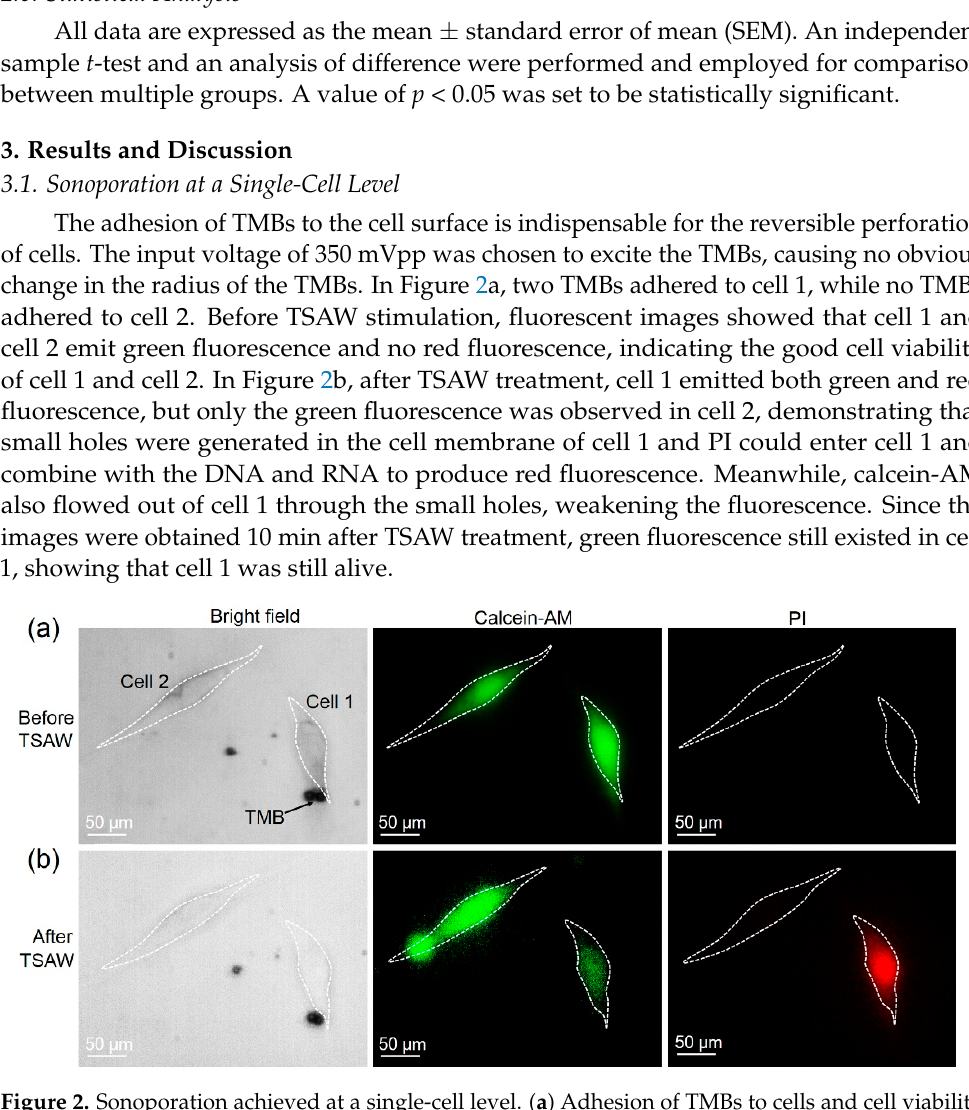
Figure 2. Sonoporation achieved at a single-cell level. ( a ) Adhesion of TMBs to cells and cell viability, before TSAW treatment. The bright field shows TMBs adhering to cell 1 but not to cell 2. Fluorescent images shows good cell viability of cell 1 and cell 2. ( b ) Sonoporation achievement of the cell adhering TMBs with TSAW treatment. The red fluorescence could be only observed in cell 1 and the green fluorescence still existed in cell 1 and cell 2.